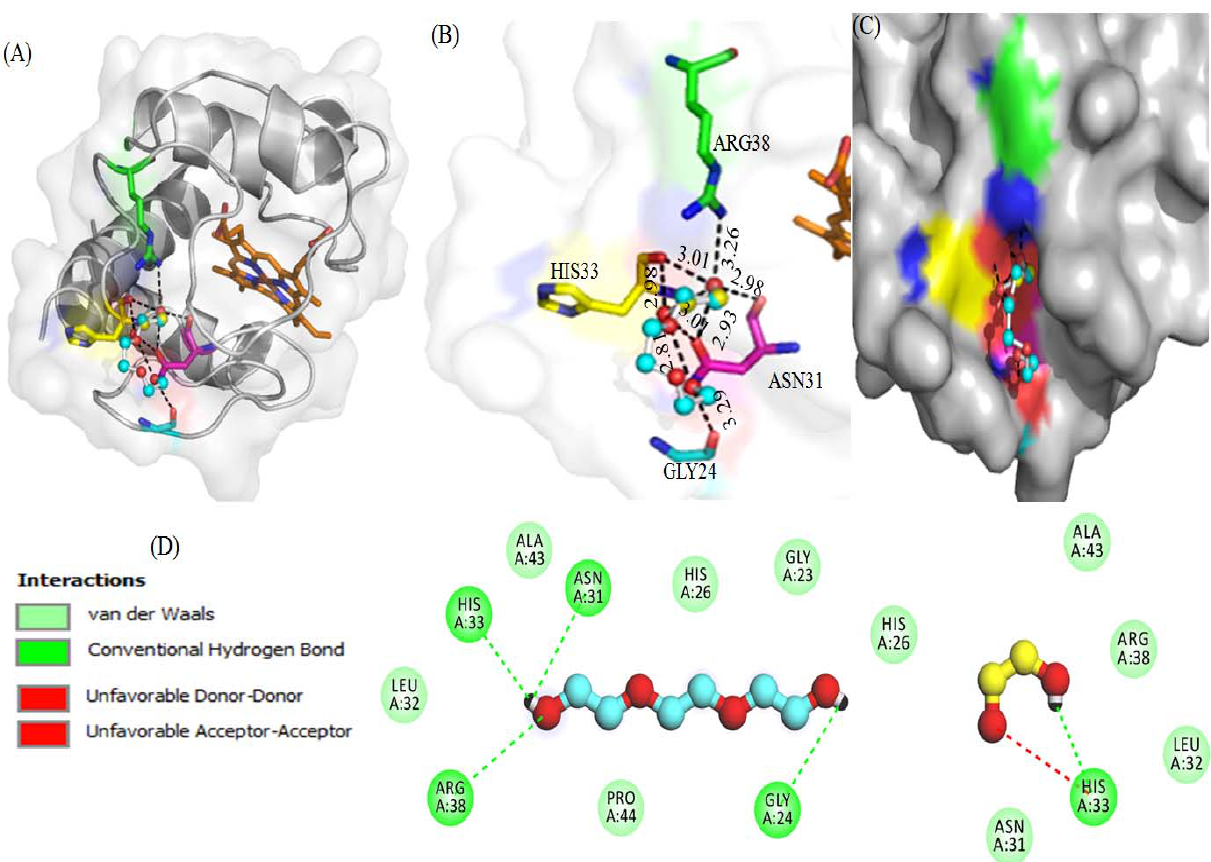
Figure 5. ( A , B ) represent interactions of crowders (i) ball and stick model of PEG 400 (blue) and (ii) EG (red ‐ pink) with amino acid residues of cyt c (cartoon model, gray). ( C ) Surface view of cyt c and the binding site for PEG 400 and EG on the protein. ( D ) 2D ‐ representation of various types of interactions between amino acid residues of the protein and crowders (PEG 400 and EG).